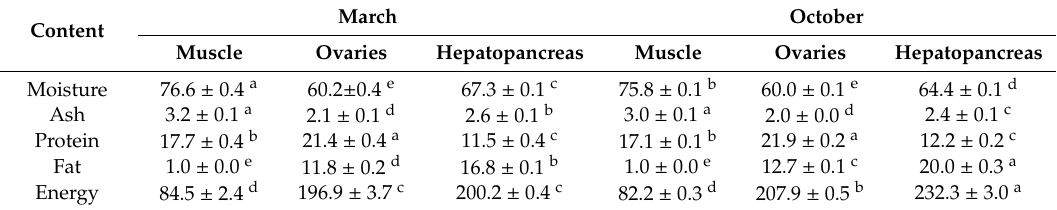
Table 2. Proximate composition (g / 100 g wet weight) and energetic value (kcal / 100 g) of the edible tissues of boiled C. maritae caught in March and October (average ± standard